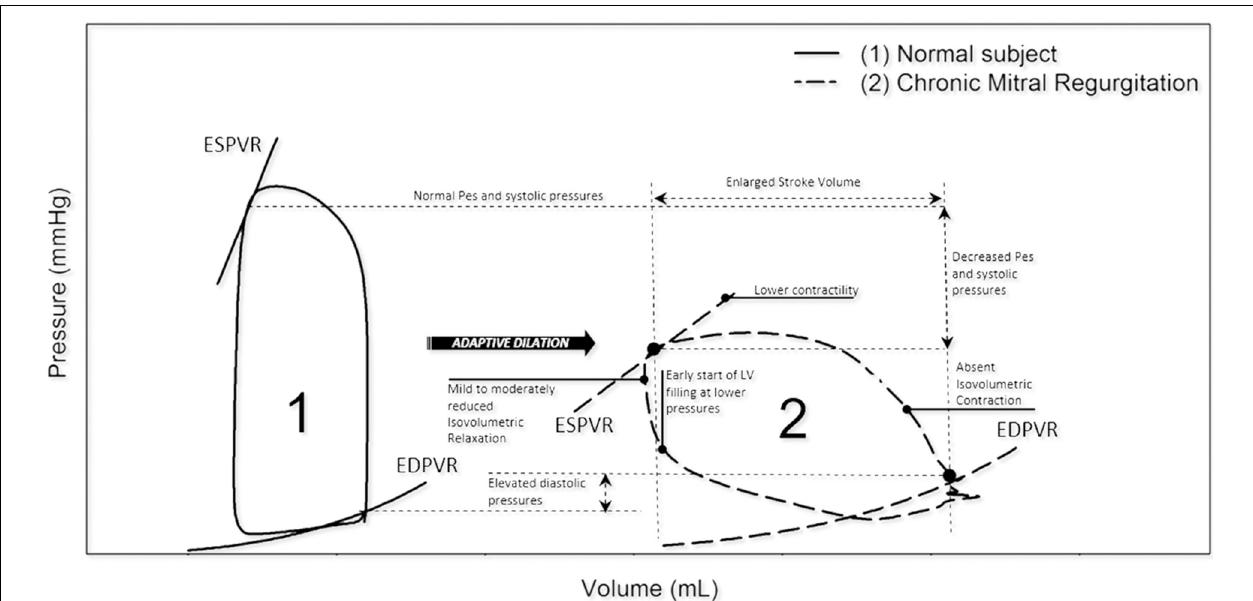
FIGURE 1 | Left ventricle pressure-volume loops in normal vs. chronic MR. In chronic MR the LV pressure-volume loop shows a rightward shift toward larger ventricular volumes with increased total stroke volume. Note that isovolumetric contraction is absent and isovolumetric relaxation is reduced. EDPVR, end-diastolic pressure-volume relation; ESPVR, end-systolic pressure-volume relation; LV, left ventricular; MR, mitral regurgitation; Pes, end-systolic pressure. Reproduced from “Invasive left ventricle pressure–volume analysis: overview and practical clinical implications” by Bastos et al. (120) Copyright by © The Author(s) 2019.